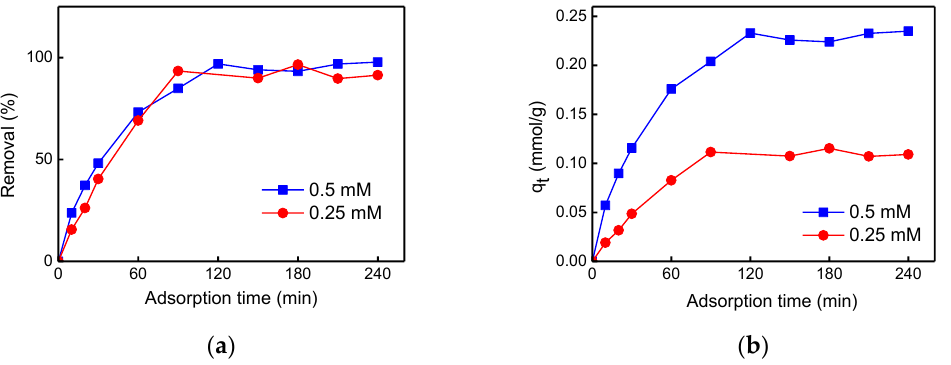
Figure 3 . Changes in ( a ) the removal efficiency and ( b ) the adsorption capacity of AERs for ethylenediaminetetraacetic acid (EDTA) with adsorption time at EDTA concentrations of 0.25 and 0.5 mM. [AERs] = 2 g/L. pH = 7.